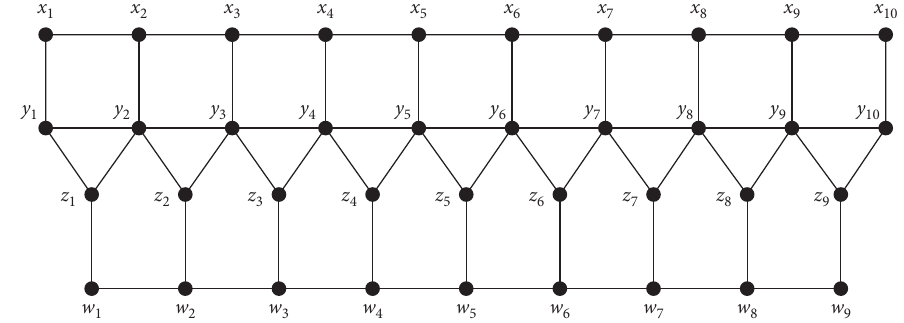
Figure 6: The planar graph P